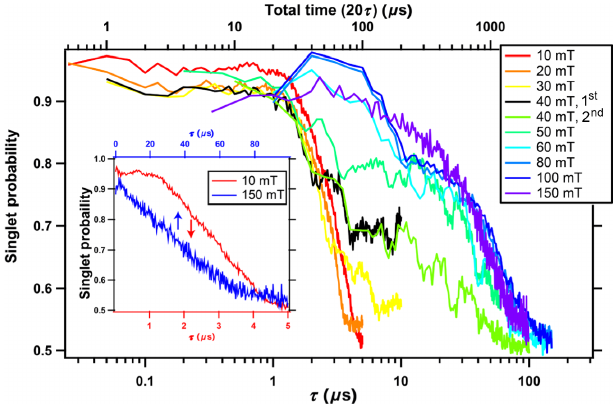
FIG. 4. CP10 echo decay curves versus τ measured with exter- nal magnetic fields ranging from 10 to 150 mT. Singlet survival times increase dramatically as the field is increased and complex decay curves appear at intermediate fields. The top axis indicates the total experiment time, 20 τ . The green and black curves at 40 mT are two separate measurements, showing that the observed structure is reproducible. Inset: 10 and 150 mT data on linear τ scales. All data are from a single device with a 5 nm thick Si well.